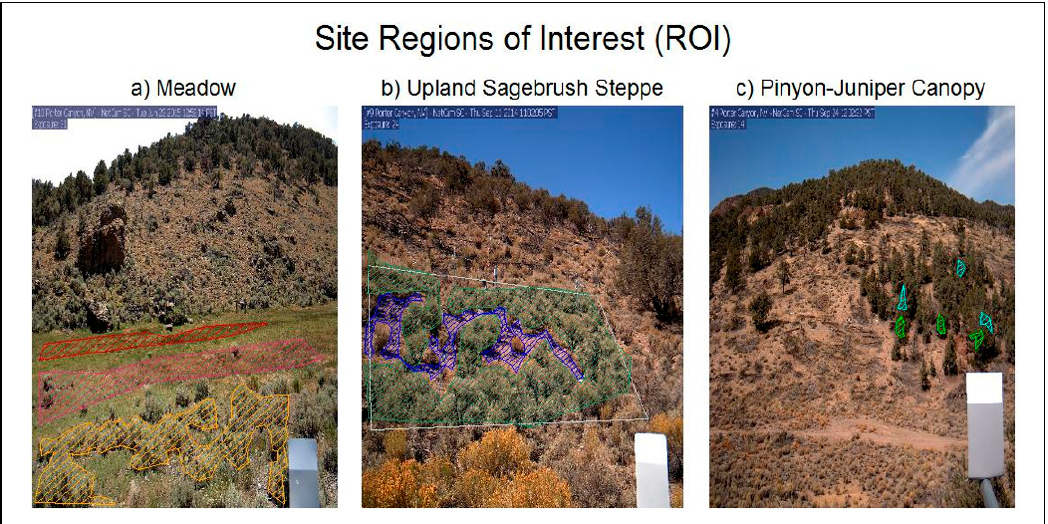
Figure 1. Regions of Interest (ROI) at three site locations. ( a ) Meadow site of wet, mesic and dry meadow sagebrush canopy in red, pink and orange respectively; ( b ) ROI for upland sagebrush steppe in white, canopy in green and interspace in blue; ( c ) Pinyon and juniper canopy site with 3 pinyon ROIs in cyan and 3 juniper ROIs in green.